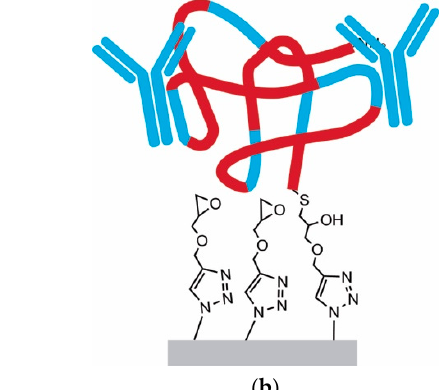
Figure 6. FT-IR spectrum of non-functionalized macroporous microclusters bearing azide on their surface (solid line) and of functionlized microclusters (dashed lines). The azide stretching band can be seen at 2100 cm − 1 .